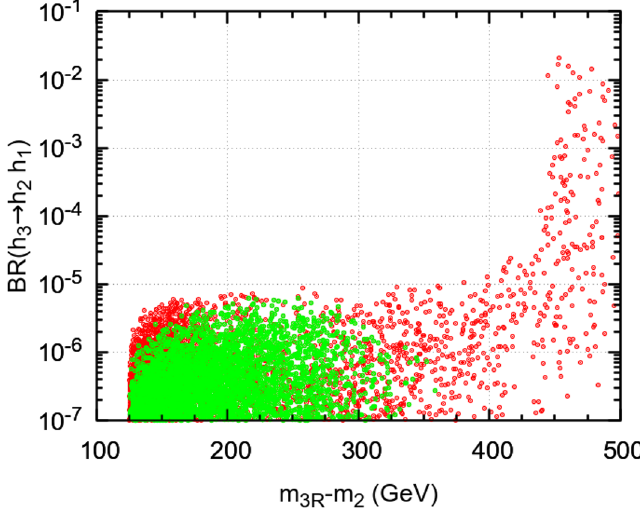
Figure 8. Tree-level branching ratio of h 3 → h 2 h 1 against the difference m 3R − m 2 . In red, points passing all constraints except HiggsBounds5 ; in green, points passing all